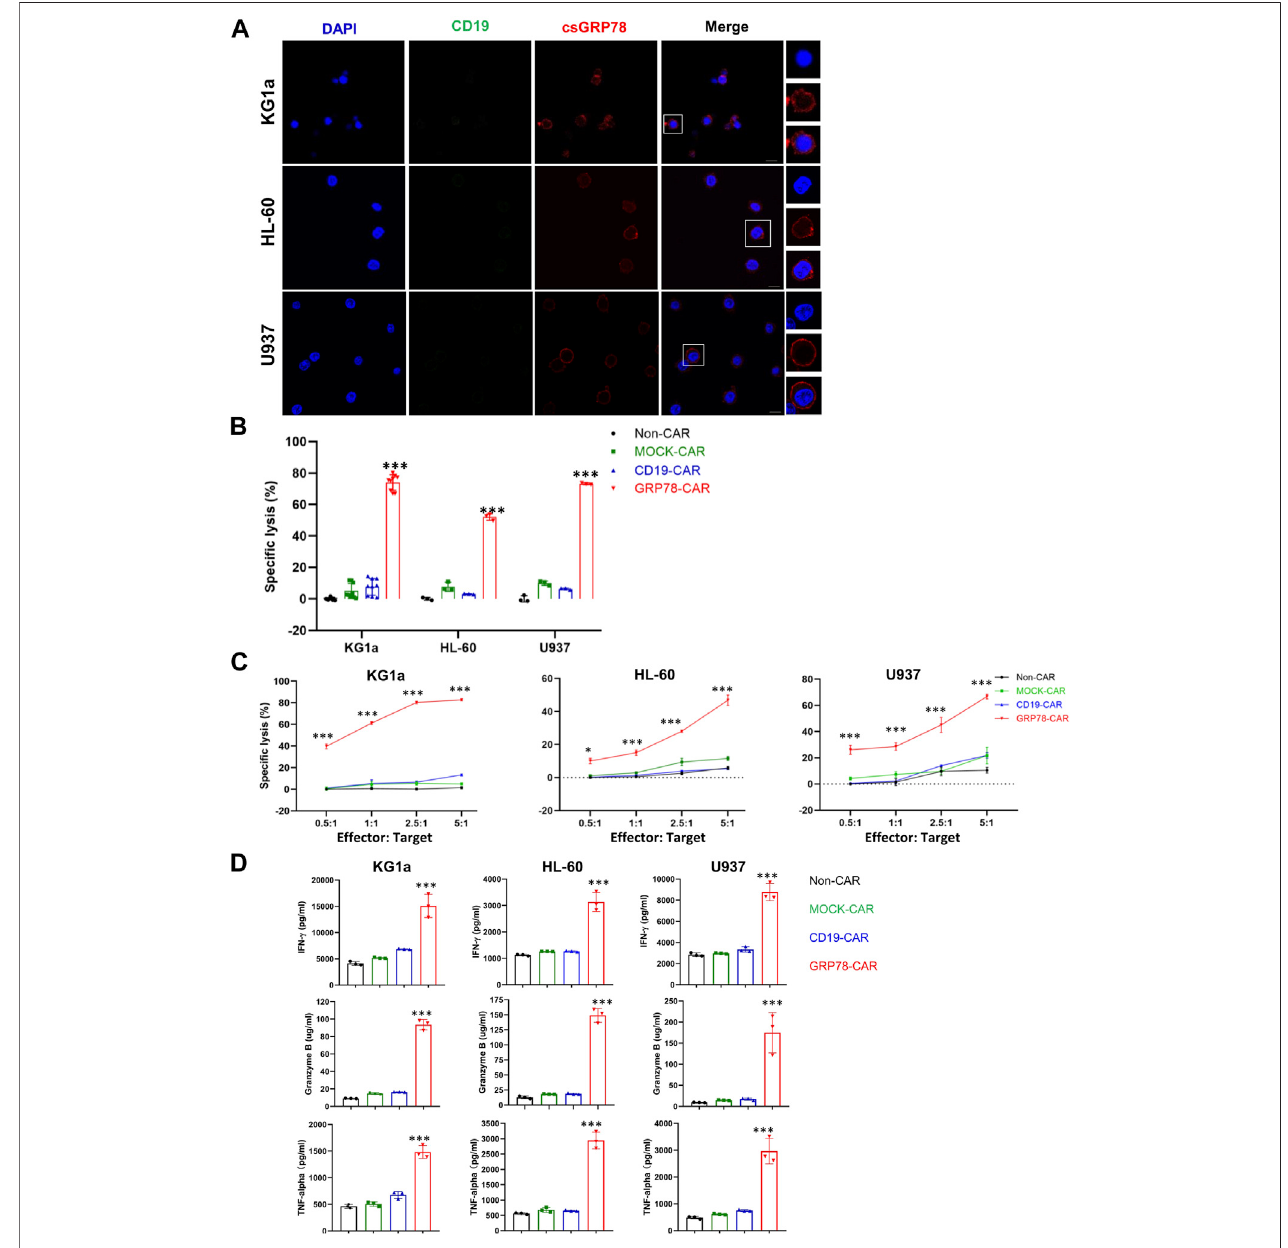
FIGURE1| Glucose-regulated protein78(GRP78) – chimericantigenreceptor(CAR) Tcellsdemonstrateanti-leukemiceffect againstacute myeloidleukemiacells. (A) Confocal image of representative immuno fl uorescence staining of cell surface GRP78 (red) and CD19 (green) on indicated leukemia cell lines. The denoted cells are zoomed on the right. The bars indicated 10 μ m length. (B) cytotoxic assay measuring the speci fi c lysis of target cells. CFSE-labeled AML cell lines KG1a, HL-60, and U937 cells were co-incubated with Non-CAR T, MOCK-CAR T, CD19-CAR T, and GRP78-CAR T cells at an effector/target (E/T) ratio of5:1 for 24 h. Experiments were repeated with at least triplicate samples. Data represent means ± SDs. Two-sided Student ’ s t-test was performed between GRP78-CAR and Non-CAR, MOCK- CAR, and CD19-CAR, *** p < 0.01. (C) leukemia cells were incubated with Non-CAR T, MOCK-CAR T, CD19-CAR T, and GRP78-CAR T cells at various (E/T) ratios as indicated.Percentagesoflysiscellsareshownasmeans±SDs.Allexperimentswererepeatedwithatleasttriplicatesamples.GRP78-CARvs . Non-CAR,MOCK-CAR, andCD19-CARTcellswiththetwo-sidedStudent ’ st-test,*** p < 0.01. (D) ELISAmeasurementsofcytokinesinterferongamma(IFN- γ ),tumornecrosisfactor – α (TNF- α ), and granzyme B in the cell supernatant were determined following 24-h incubation of target cells with speci fi ed CAR-T cells. Two-side Student ’ s t-test was performed between GRP78-CAR T cell treatment and Non-CAR, MOCK-CAR, and CD19-CAR T cells. All experiments were repeated with at least triplicate samples. Data represent means ± SDs. *** p < 0.01.